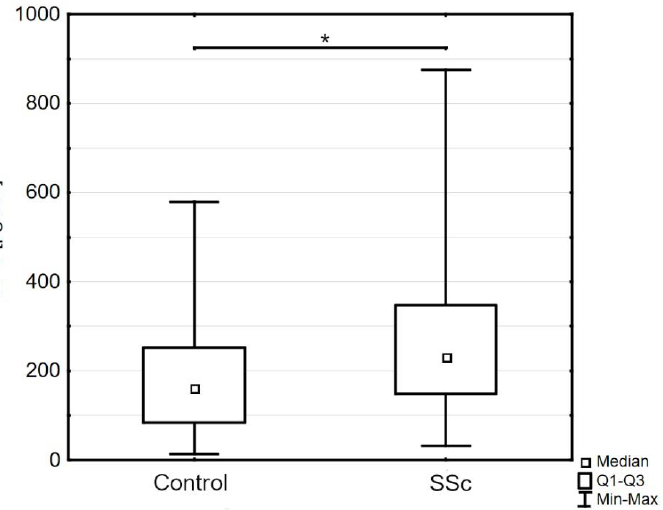
Figure 1. The serum concentration of lipopolysaccharides (LPS) in patients with systemic sclerosis compared to controls; SSc – systemic sclerosis; Q1 – the first quartile; Q3 – the third quartile; Min – the lowest value; Max – the highest value (* p < 0.05).